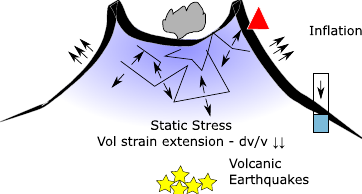
summit, yellow stars to earthquakes, blue and red colors to extensive and com- pressive strains, respectively, and the blue rectangle on the eastern fl ank to the water level in the well at